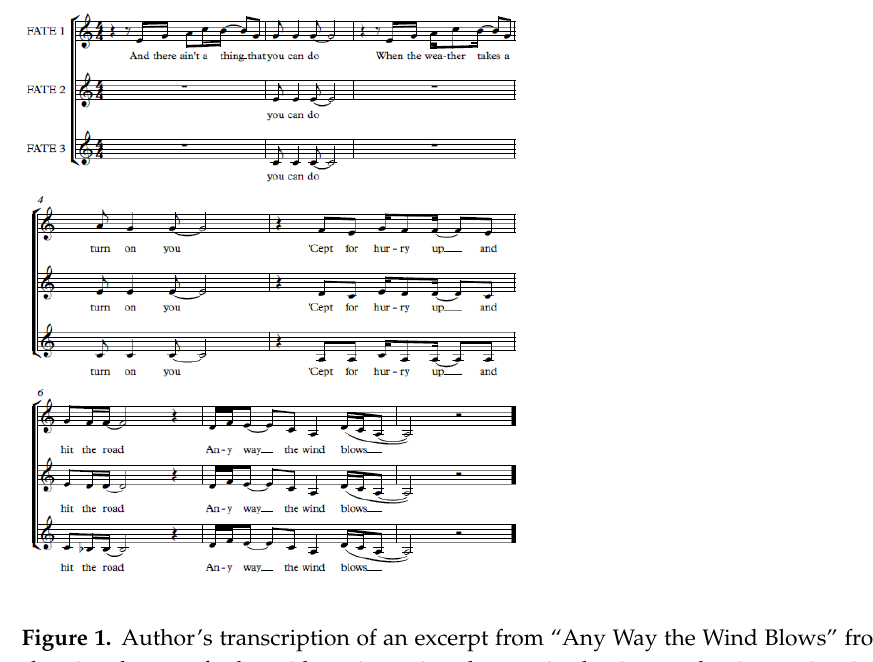
Figure 1. Author’s transcription of an excerpt from “Any Way the Wind Blows” from Hadestown showing the use of solos with resting voices, harmonized voices, and unison voices in quick succes- sion. In some Broadway performances, the solo in the third measure is taken by Fate 2. The orbifold path model can distinguish the two different